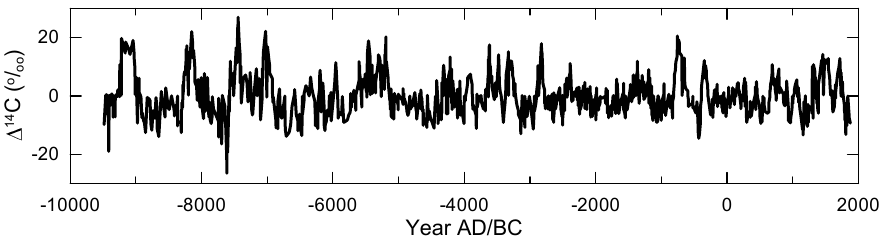
Fig. 6. Atmospheric radiocarbon 14 C differential concentrations (expressed as devia- tion, in h , from the ∆ 14 C long-term decline curve shown in Figure 1 of Solanki et al. 2004). The ∆ 14 C measurement precision is generally 2–3 h , although in the earlier part of the time series it can reach up to 4–5 h . The peaks are significant at the 4 (cid:27)